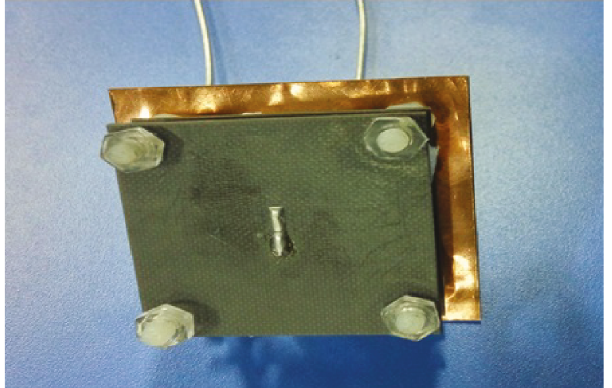
Figure 9: The physical photo of dual polarized